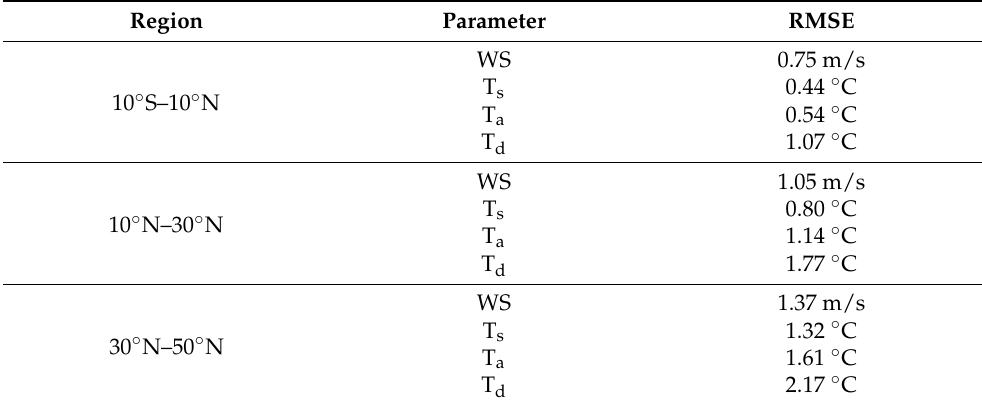
Table 3. The root-mean-square error (RMSE) of multi-parameter BPNN model-retrieved sea surface wind speed (WS), sea surface temperature (T s ), near-surface air temperature (T a ), and dewpoint temperature (T d ) for three geographic regions.